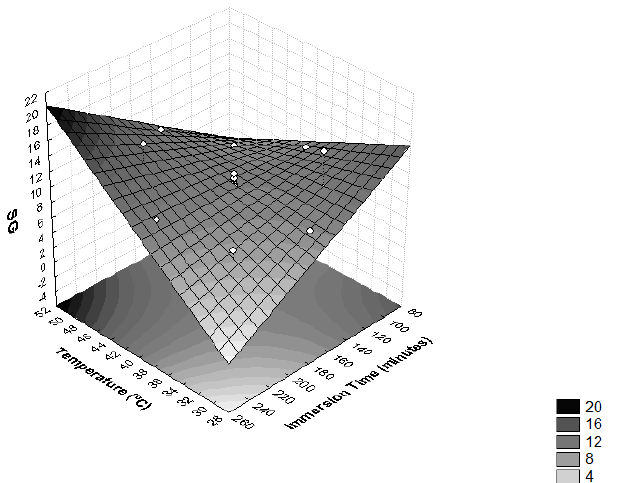
Figure 2. Surface response for solid gain (SG) as a function of immersion time (minutes) and temperature (°C).